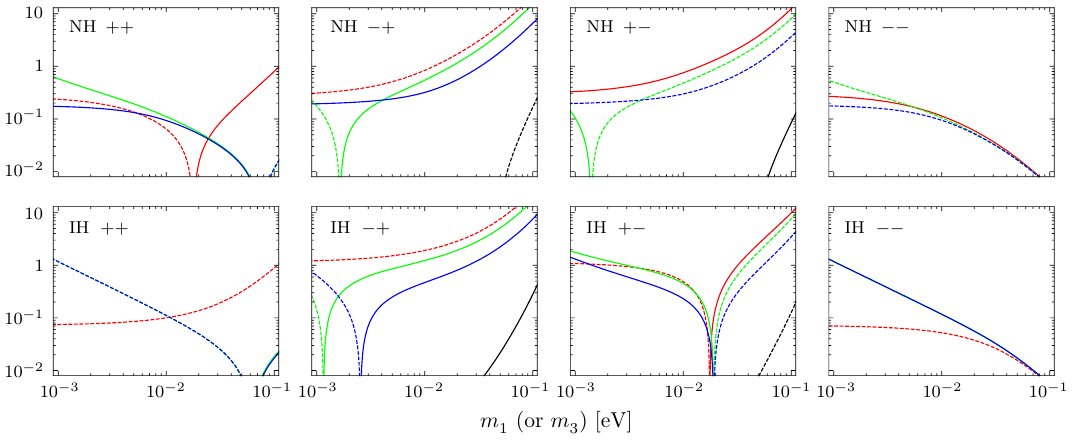
Figure 3 . The mixing-parameter deviations induced by R green and (cid:1) (cid:27) in blue) against the lightest neutrino mass m various combinations of (cid:26) (0) and (cid:27) (0) with (cid:14) (0) = (cid:0) (cid:25)= 2. The signs ++ ; (cid:0) + ; + (cid:0) and (cid:0)(cid:0) respectively stand for [ (cid:26) (0) ; (cid:27) (0) ] = [0 ; 0] ; [ (cid:25)= 2 ; 0] ; [0 ; (cid:25)= 2] and [ (cid:25)= 2 ; (cid:25)= 2].